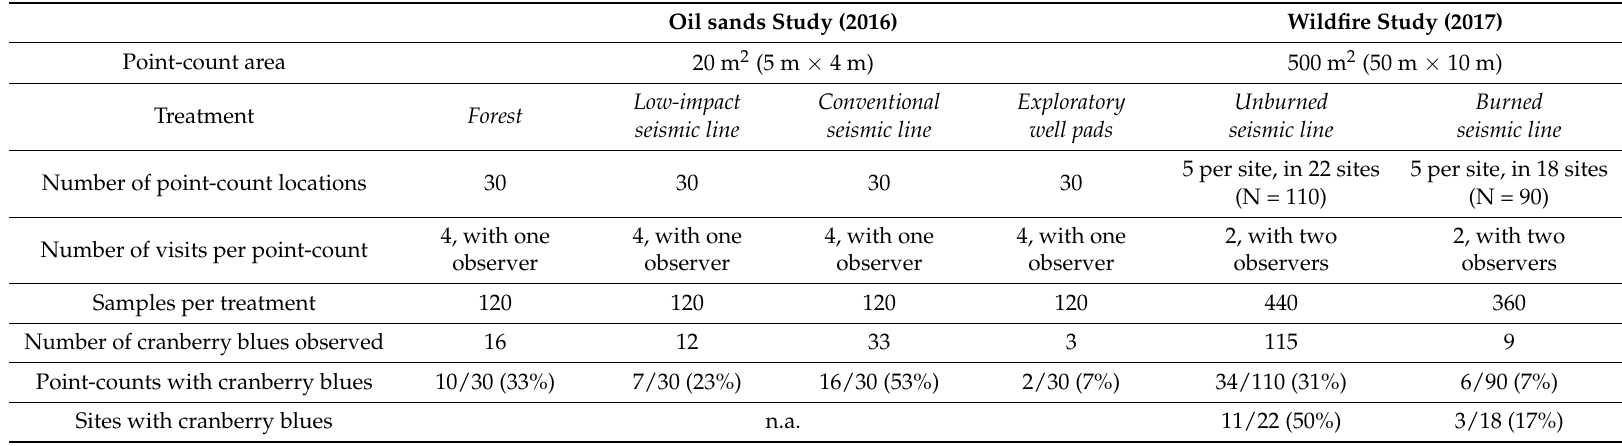
Table 1. Summary of experimental design and summarized results for point-counts that estimate abundance of Cranberry blue